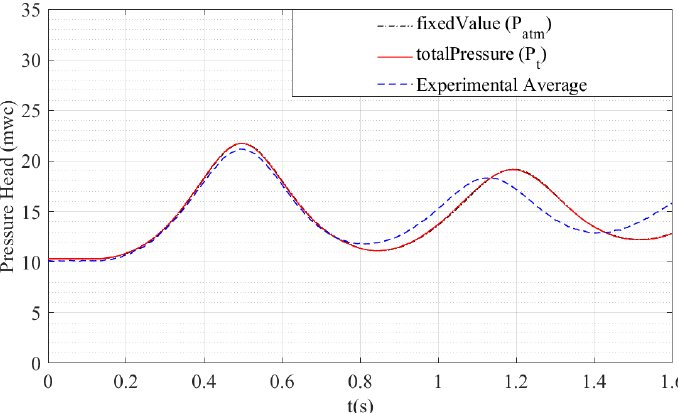
Figure 6. Influence of the outlet boundary condition over the behaviour of the air pocket.